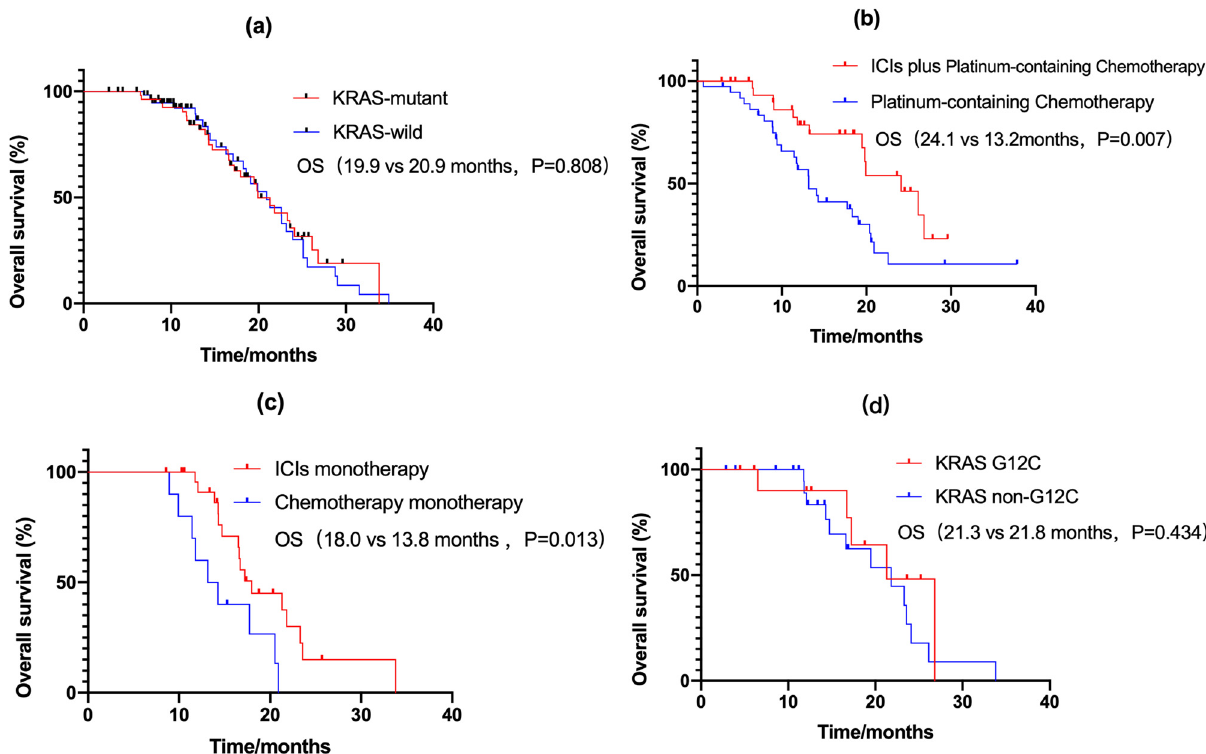
Figure 2: OS ( a ) OS of KRAS - mutant and KRAS - wild type; ( b ) OS of fi rst - line; ( c ) OS of second - line; ( d ) OS of KRAS - mutant subtypes. OS: overall survival.